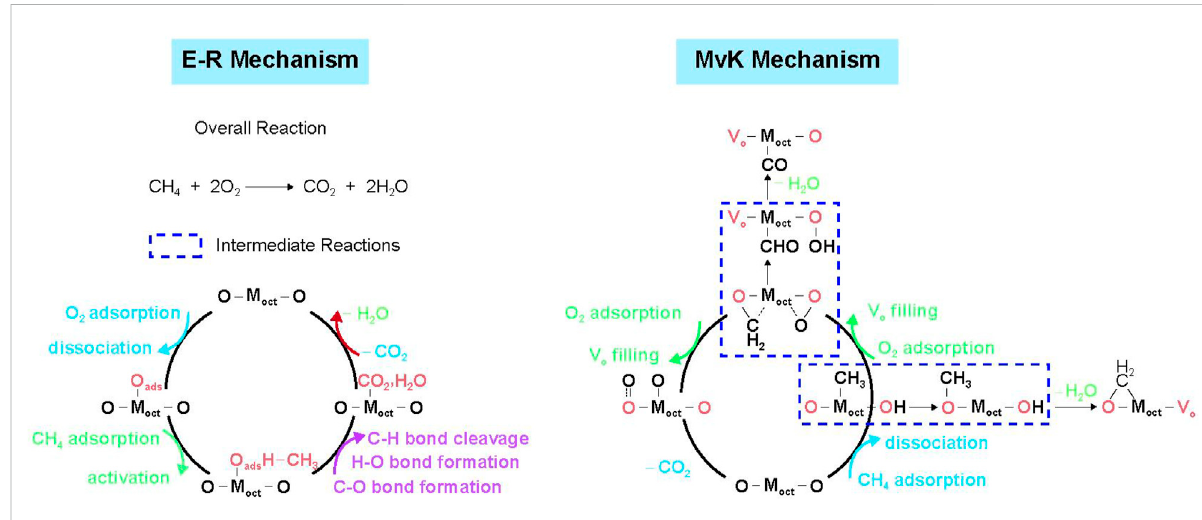
FIGURE 3 The proposed reaction pathways based on the E – R mechanism for Ni-poor spinel oxides and MvK mechanism for Ni-rich spinel oxides. Cited from Wang H. W. et al. (2019).